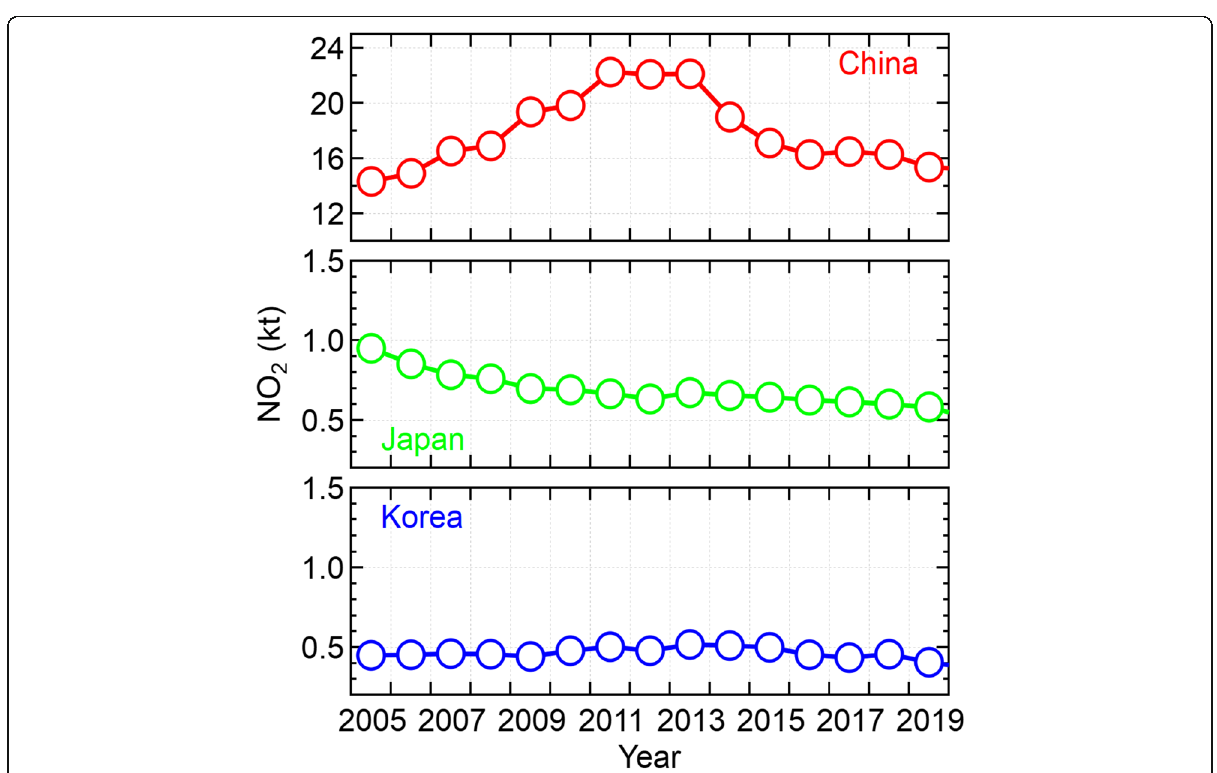
Fig. 6 Updated results of a trend analysis using OMI tropospheric NO 2 VCD data by Irie et al. (2016). Temporal variations in annual mean tropospheric NO 2 burdens over the entire national area of China (red), Japan (green), and South Korea (blue) are shown. The burdens were estimated by multiplying the annual averages of OMI tropospheric NO 2 VCD data over the entire national area by the area of each